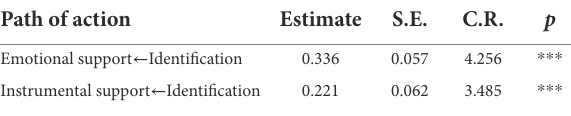
TABLE 5 Path coefficients and significance levels between identification and